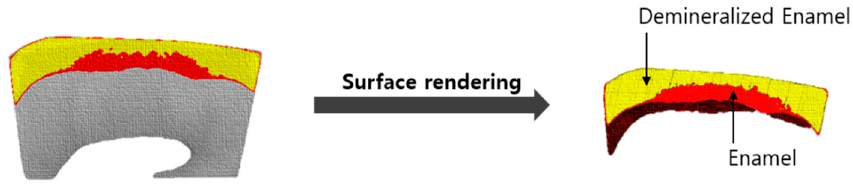
Figure 4. The demineralized enamel 3D images were generated by surface rendering.